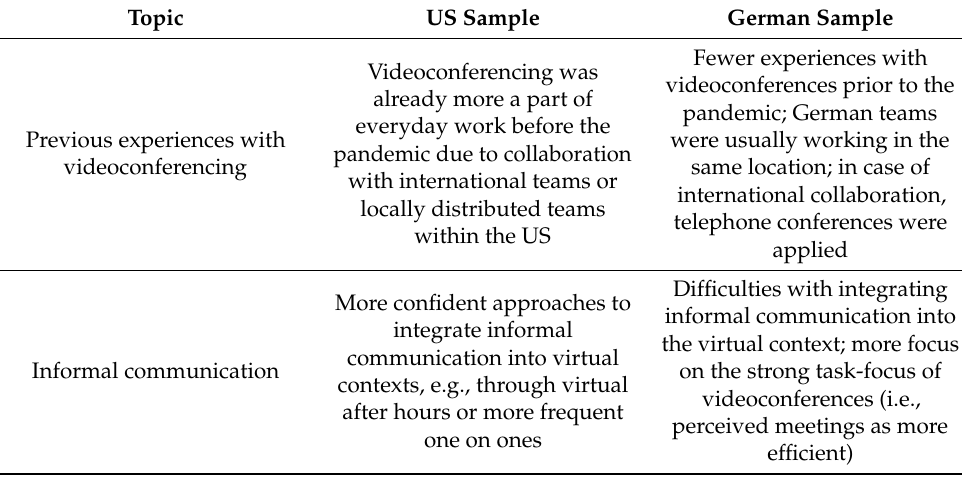
Table 3. Cultural Comparison from Study 2: Topics Where Cultural Differences